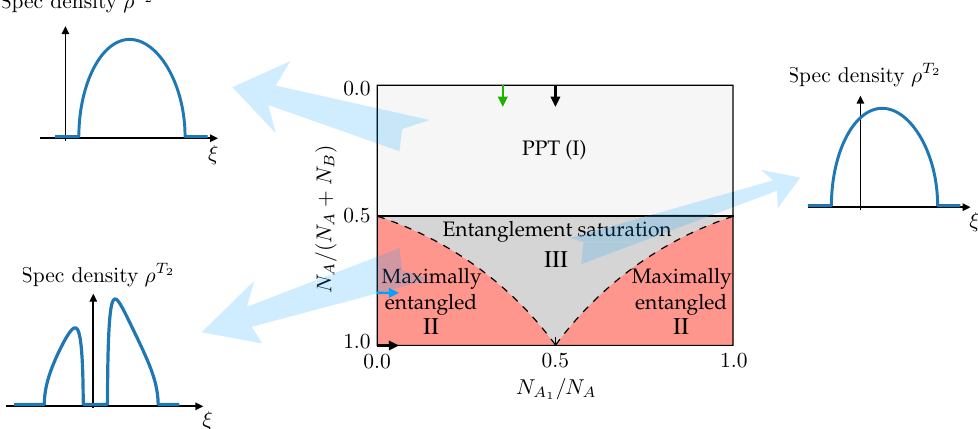
FIG. 2. Phase diagram of reduced density matrix ρ A obtained from random pure (Page) states. The size of the environment B grows along the vertical axis, while the horizontal axis characterizes the relative size of A partitions. The horizontal line at the bottom N B = 0 corresponds to pure states where the Page transition occurs at N A shown for each phase. Arrows (color coded) indicate the paths along which LN is plotted in Fig.